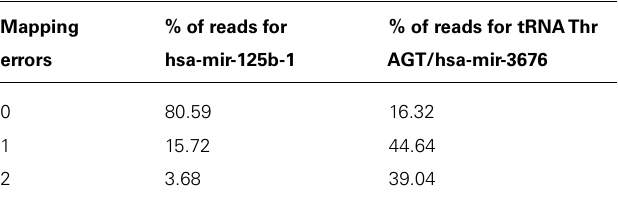
Table 2 | Mapping error